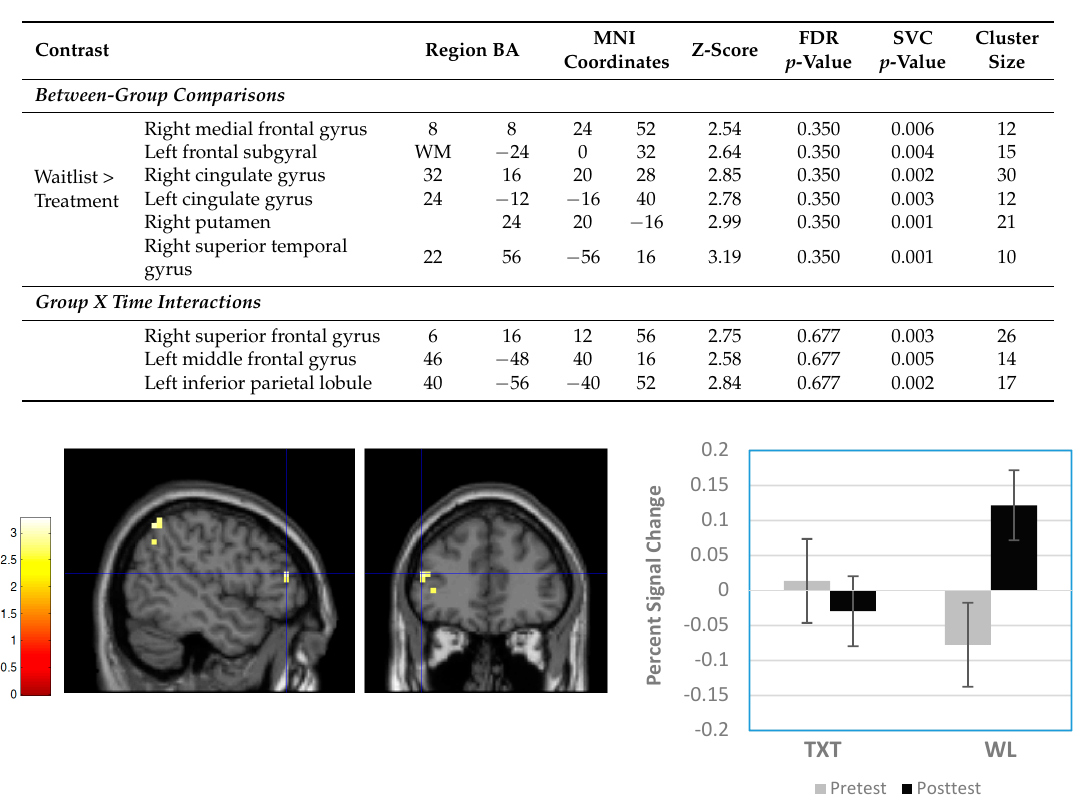
Table 3. Significant findings from whole-brain analyses with the Small-Volume Correction applied.